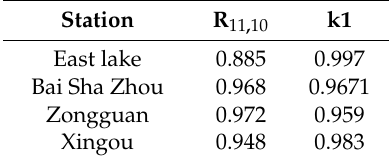
Table 5. R 11,10 and AWV parameter k1 of four monitoring